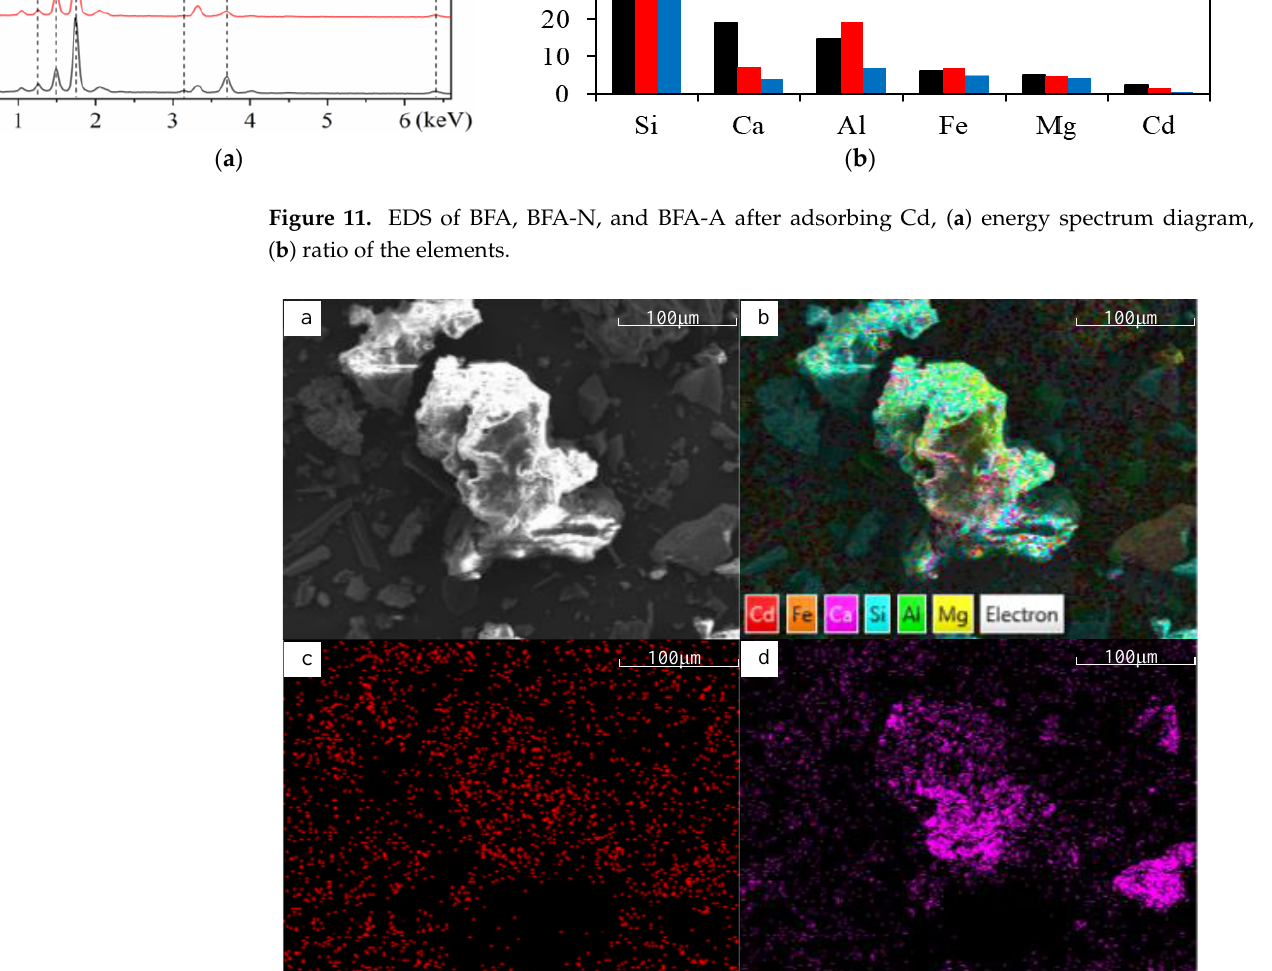
Figure 13. SEM of BFA-A after adsorbing Cd, ( a ) electron image, ( b ) EDS layered image, ( c ) Cd, ( d ) Ca.